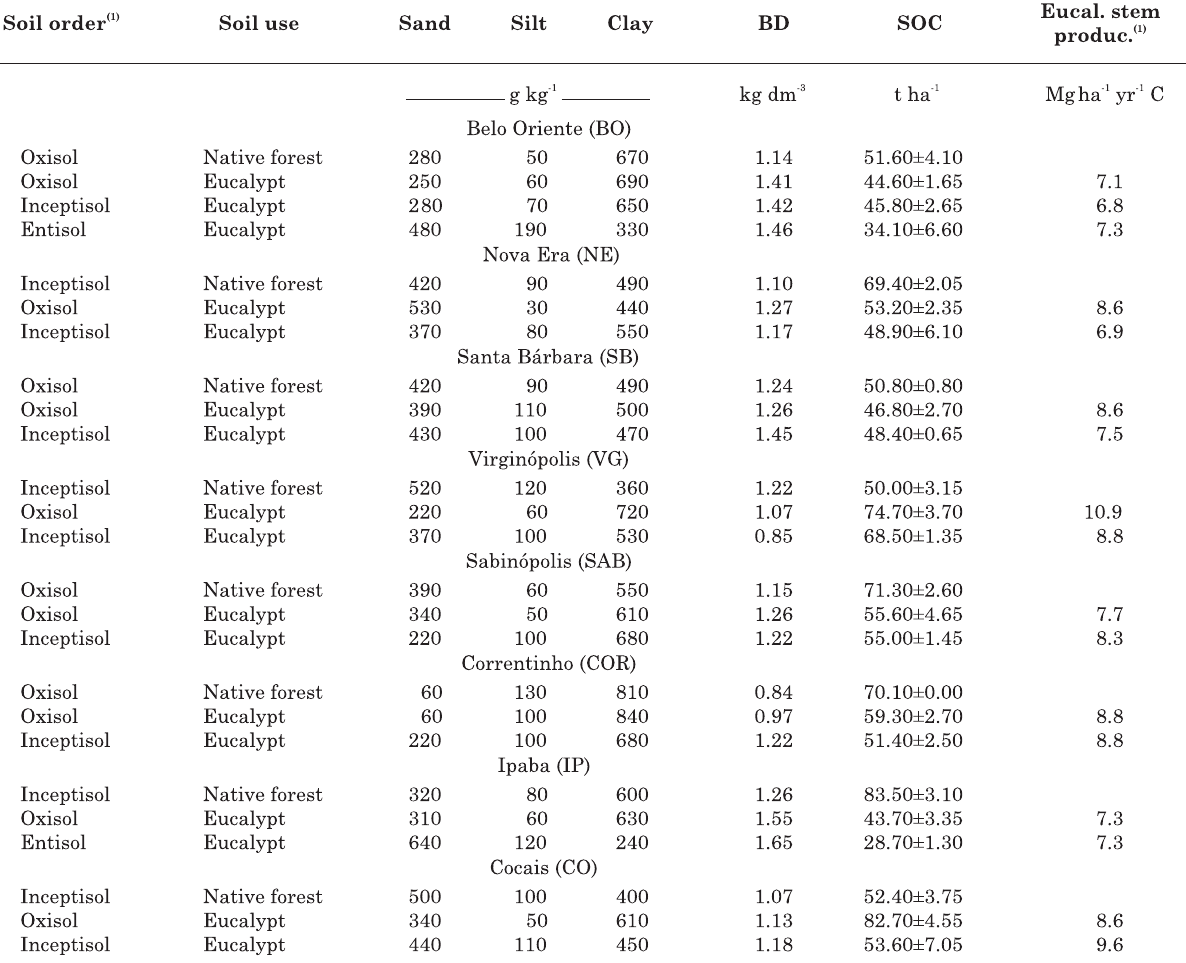
Table 3. Soil order, use, texture, bulk density soil organic carbon (0–20 cm ) of soils under native forest